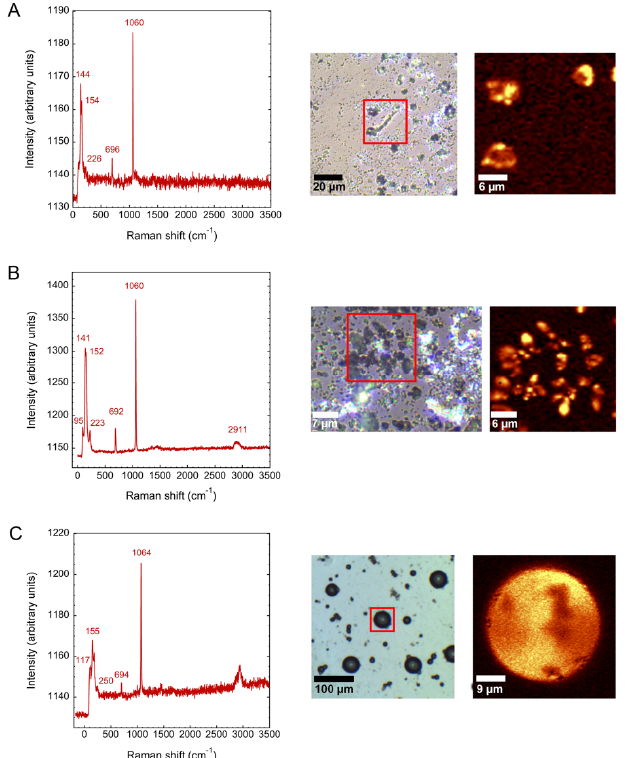
Figure 7. Raman spectroscopic analysis of witherite silica carbonate biomorphs obtained in different conditions. ( A ) Control in the absence of enzyme. ( B ) Suberitis domuncula silicatein- α . ( C ) Tethya aurantia silicatein- α . Left panels correspond to the Raman spectra. Right panels correspond to the optical image and mapping at the most intense Raman signal.